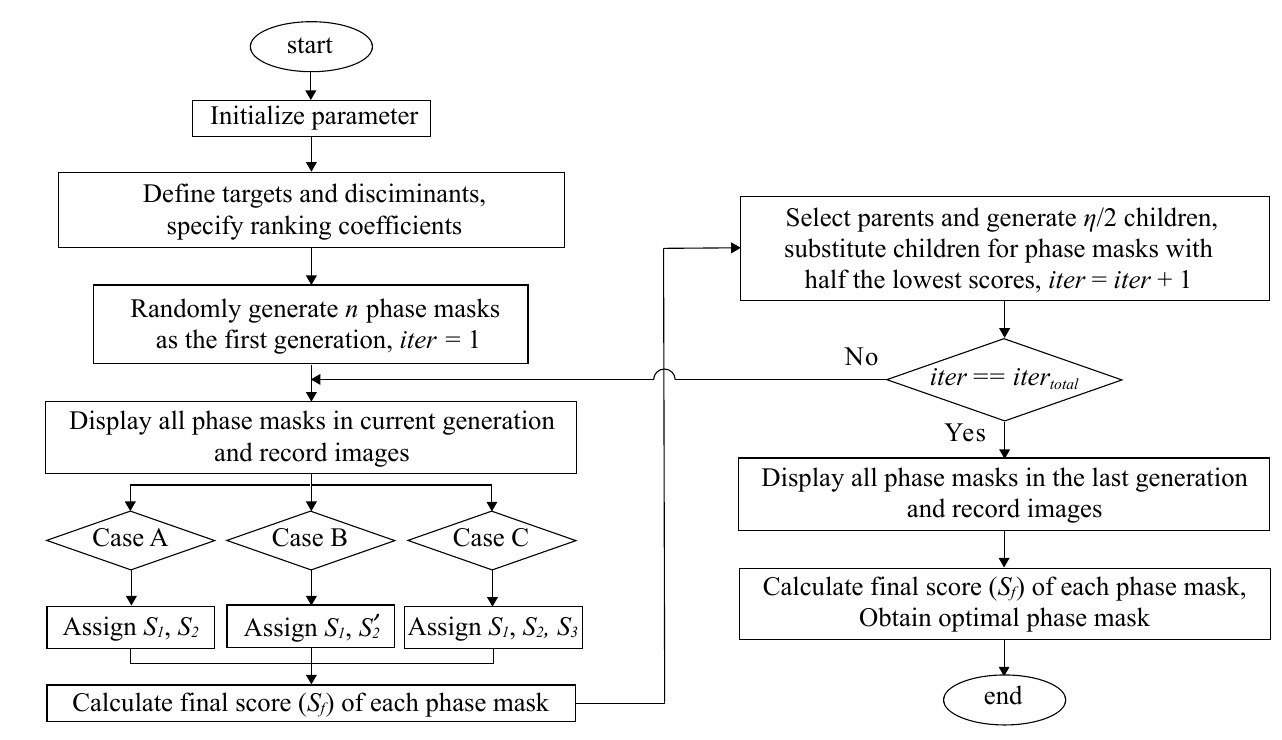
Figure 2. Flowchart of SBGA for wavefront